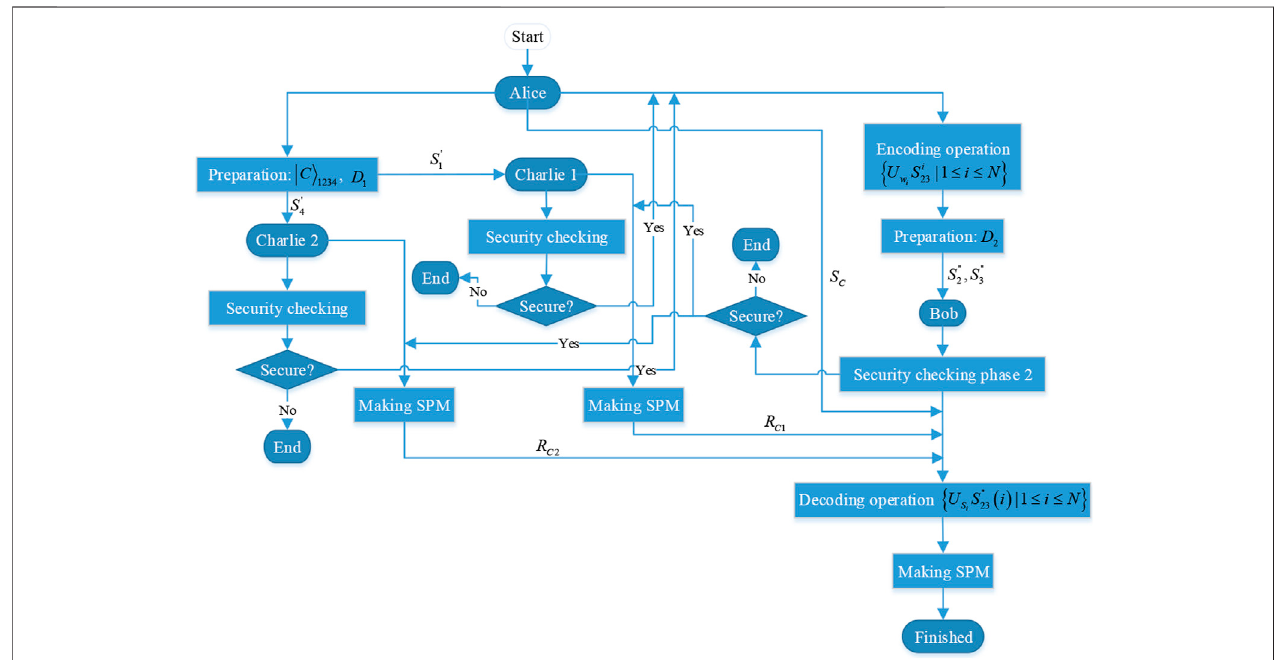
FIGURE 1 | The executing process of the whole communication protocol. SPM denotes single-particle measurements with Z -basis.